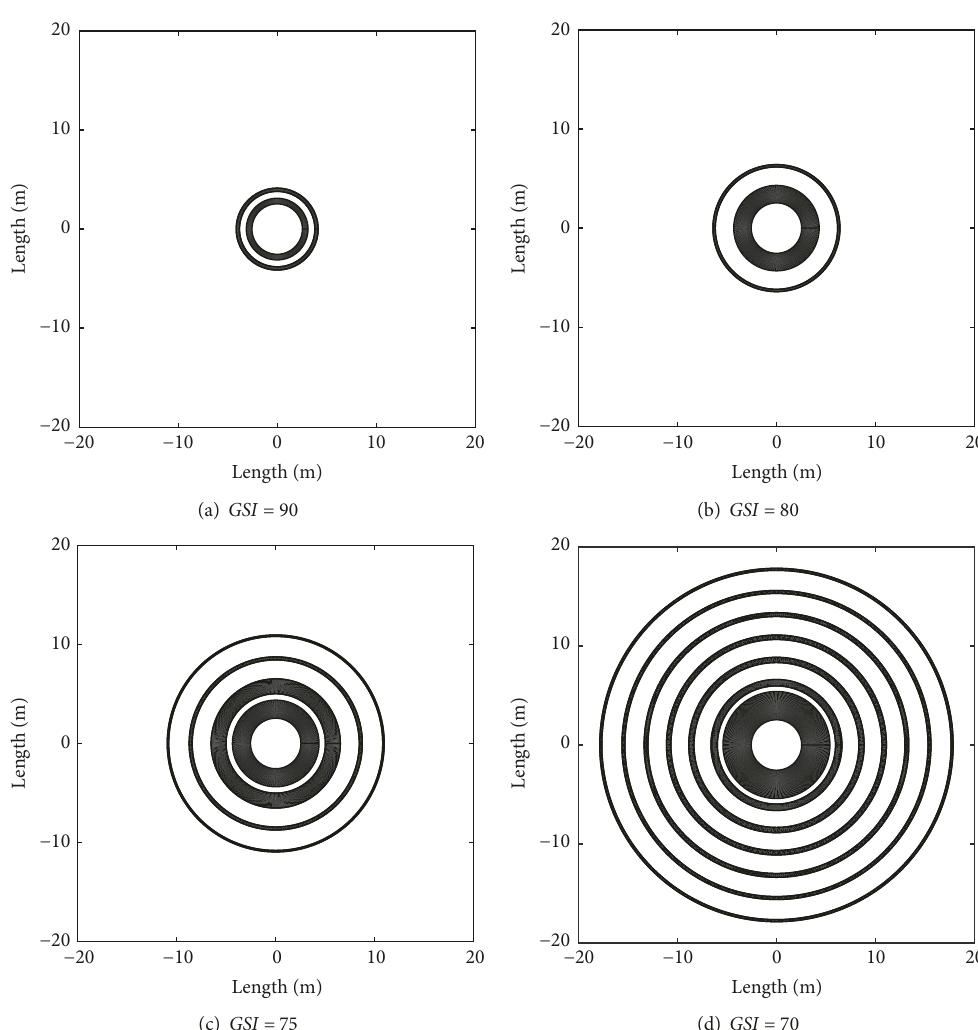
Figure 5: Effect of geological strength index ( GSI ) on zonal